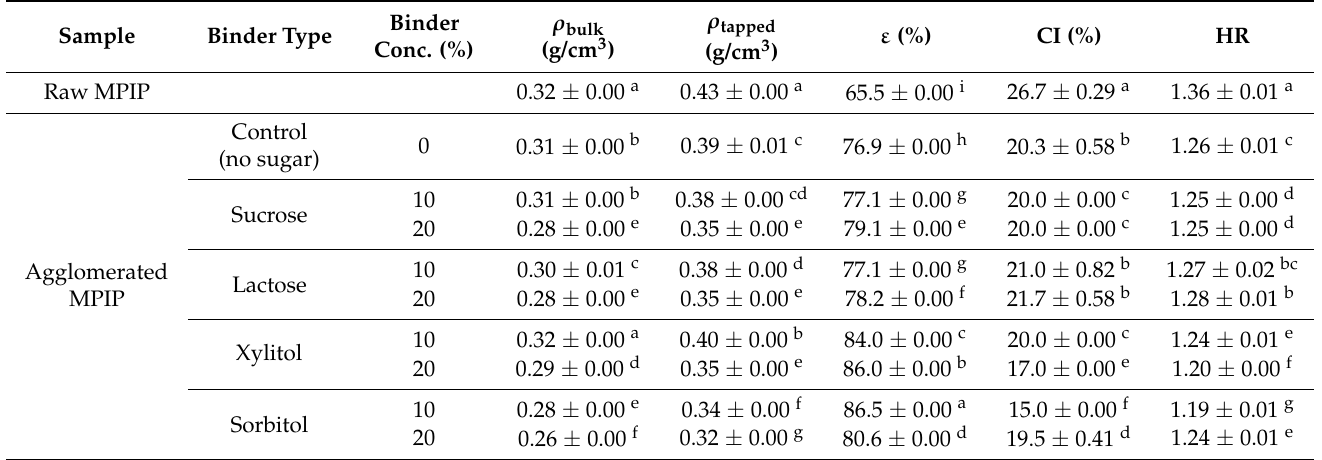
Table 2. Flow characteristics and porosity of raw and agglomerated MPIPs prepared with various sugar binders at different